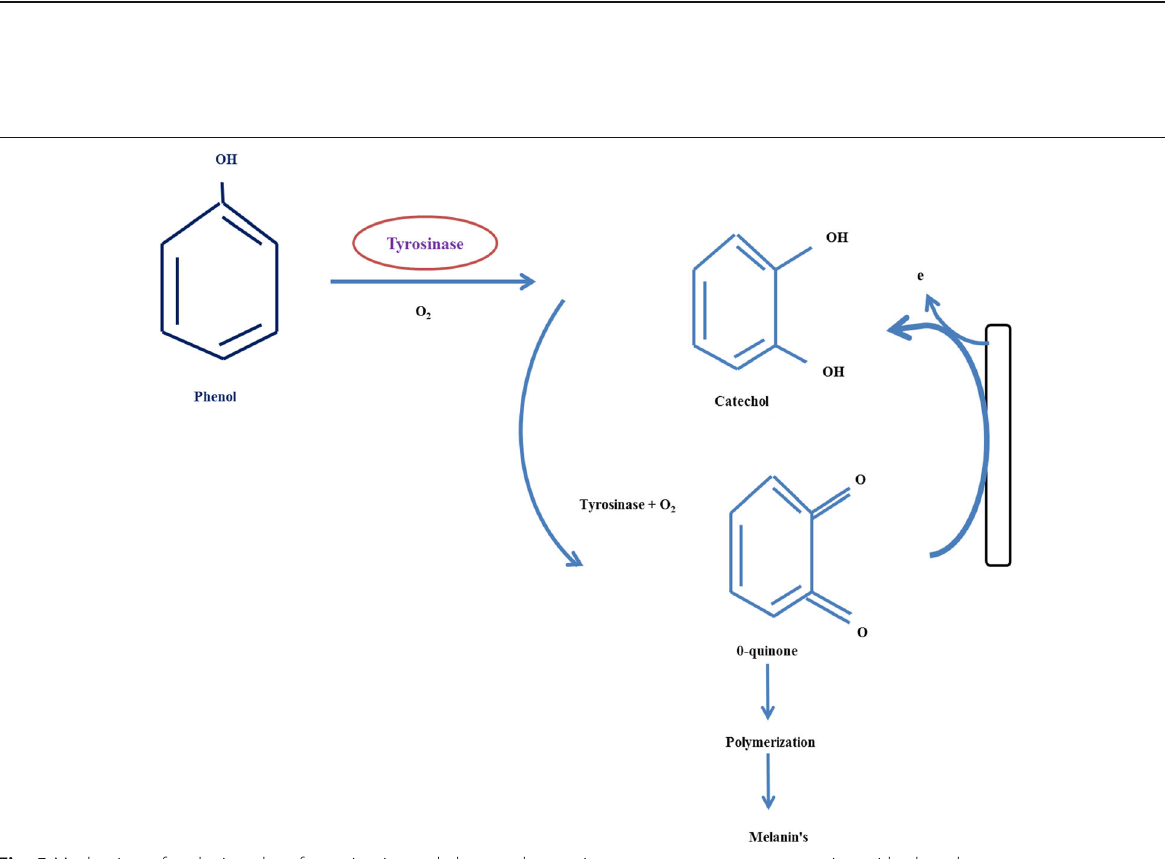
Fig. 4 Complementary gene interaction in the development of aleurone layer colour through standard phenol and modified phenol tests in rice seed giving rise to the phenotypic ratio of 9:7 (brown/dark brown: light brown/no reaction) in F 2 progenies